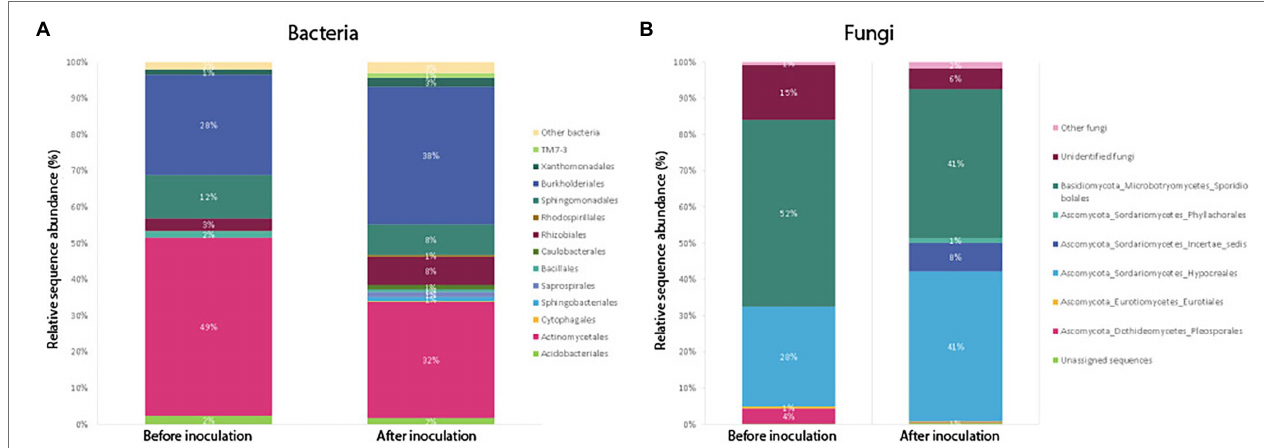
FIGURE 5 | Average relative abundance of sequences belonging to bacterial (A) and fungal (B) orders, compared between samples harvested before (Harvest 1) and after inoculation (Harvest 2). For Harvest 1 and Harvest 2, the bars show an average community composition based on a combination of all samples from that harvest. Sequences were classified to the level of orders, and orders representing less than 1% of the community have been grouped as